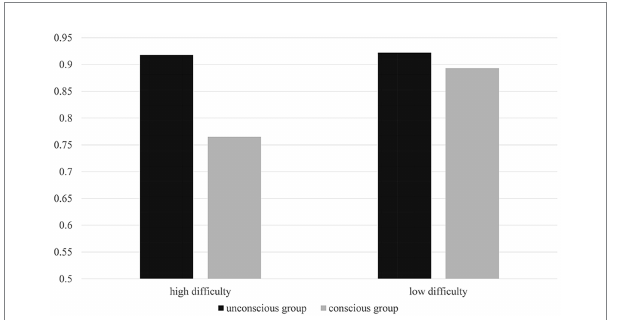
FIGURE 1 The prototype activation rate of Experiment 1.